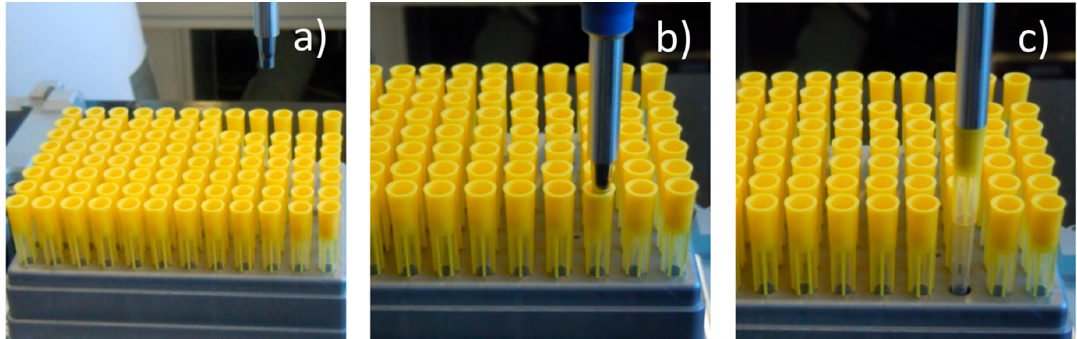
Figure 8. Tip load using the pipette, BRL 200/1: ( a ) Pipette positioning above the tip to be loaded,